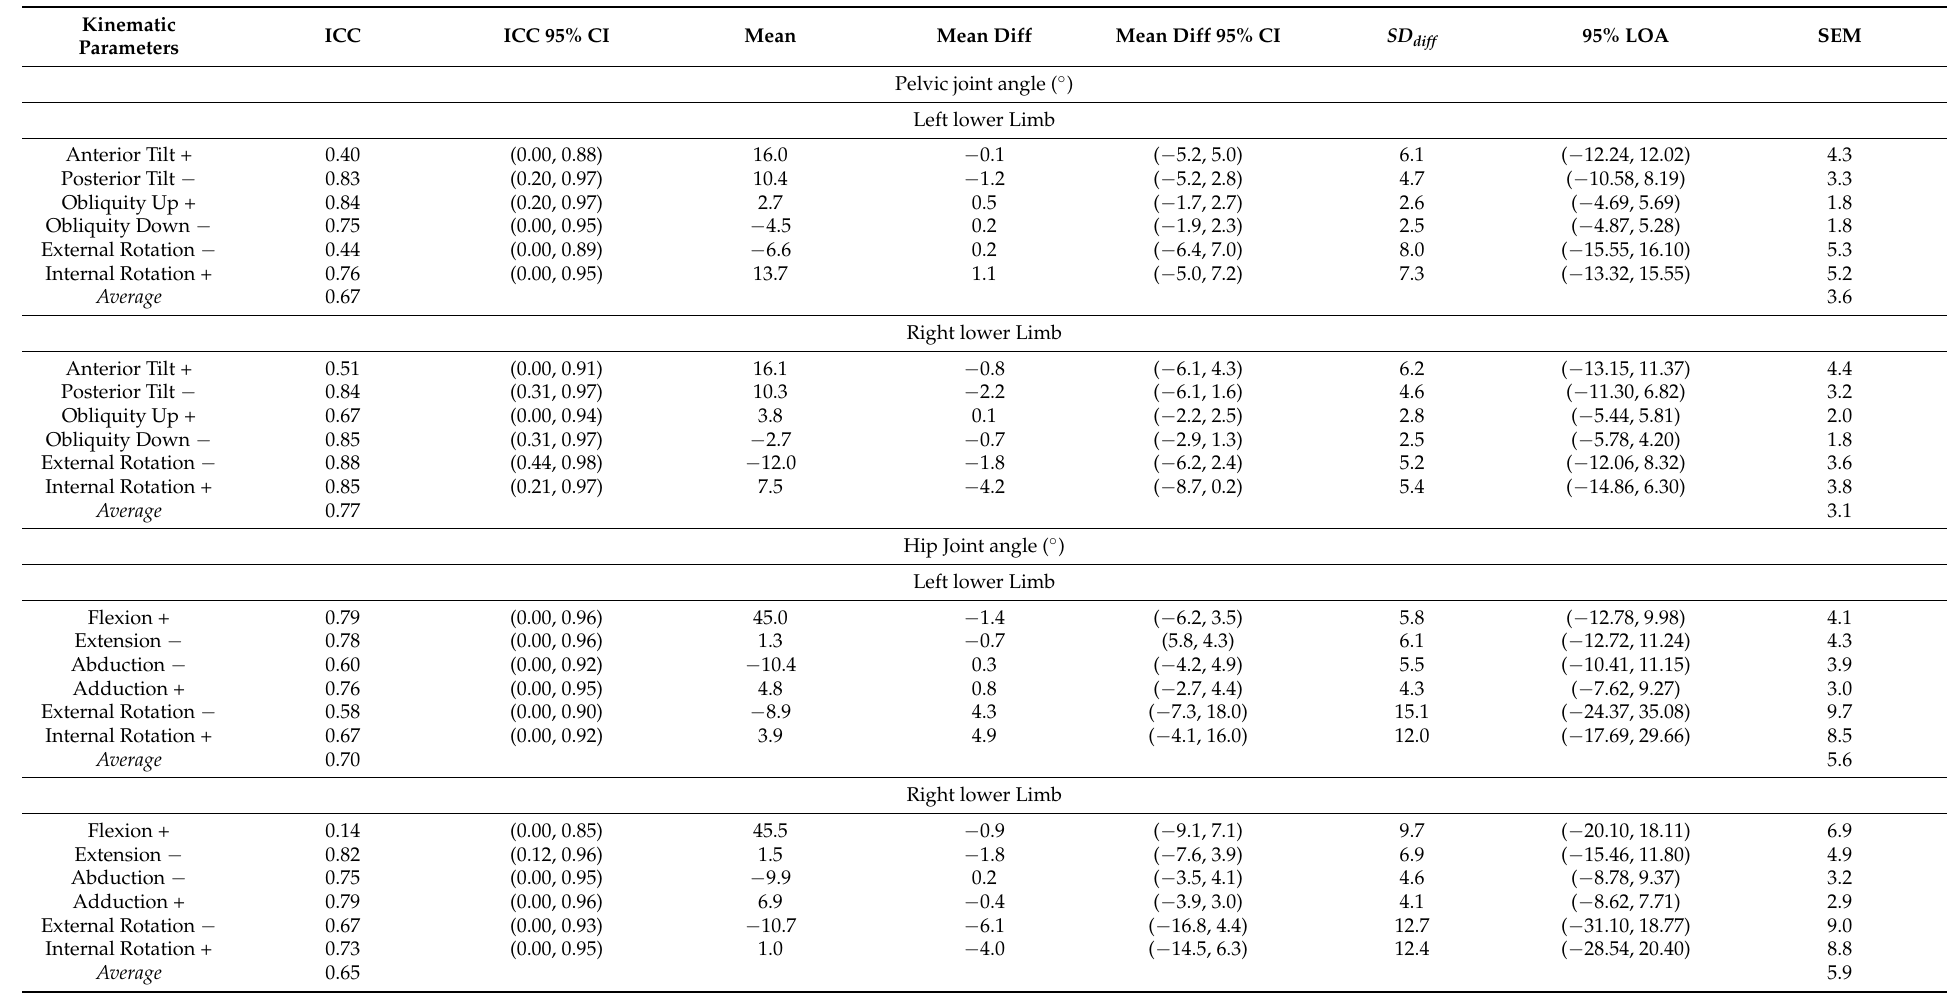
Table 4. Reliability values for kinematic